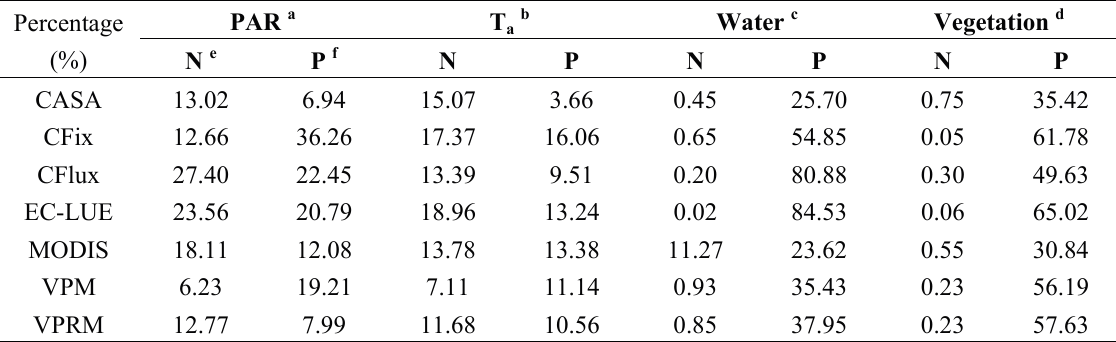
Table 3. Percentage of vegetated areas with significant correlations between GPP estimates and environmental variables and vegetation